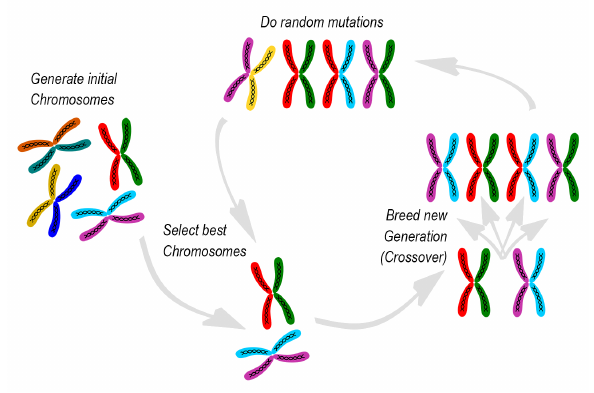
Figure 7. The life cycle of a Genetic